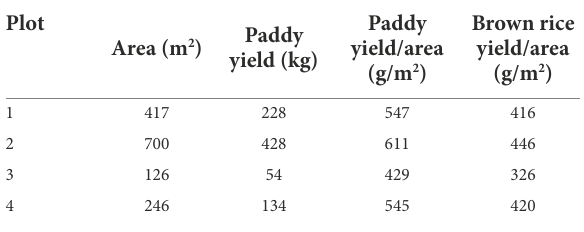
TABLE 1 Grain yield of each